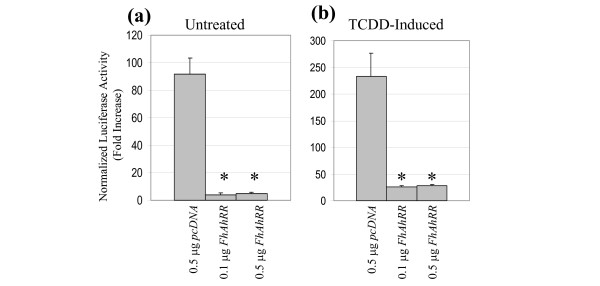
Aryl hydrocarbon receptor (AhR) repressor (FhAhRR) inhibits AhR-dependent pGudLuc reporter activity. Hs578T cells were left untransfected or were transfected with 0.5 μg/well renilla luciferase vector phRL-TK and 0.1 μg pGudLuc/well together with 0.5 μg control vector (pcDNA), 0.1 μg FhAhRR, or 0.5 μg FhAhRR in the (a) absence or (b) presence of 10-9 M 2,3,7,8-tetrachlorodibenzo-p-dioxin (TCDD). Cells were harvested 18 hours later and luciferase activity assayed. Firefly luciferase activity was normalized to renilla activity in each experiment. Data pooled from six experiments are presented as the average fold increase relative to non-transfected cells + standard error. An asterisk (*) indicates a significant difference relative to pcDNA-transfected controls, p < 0.001.